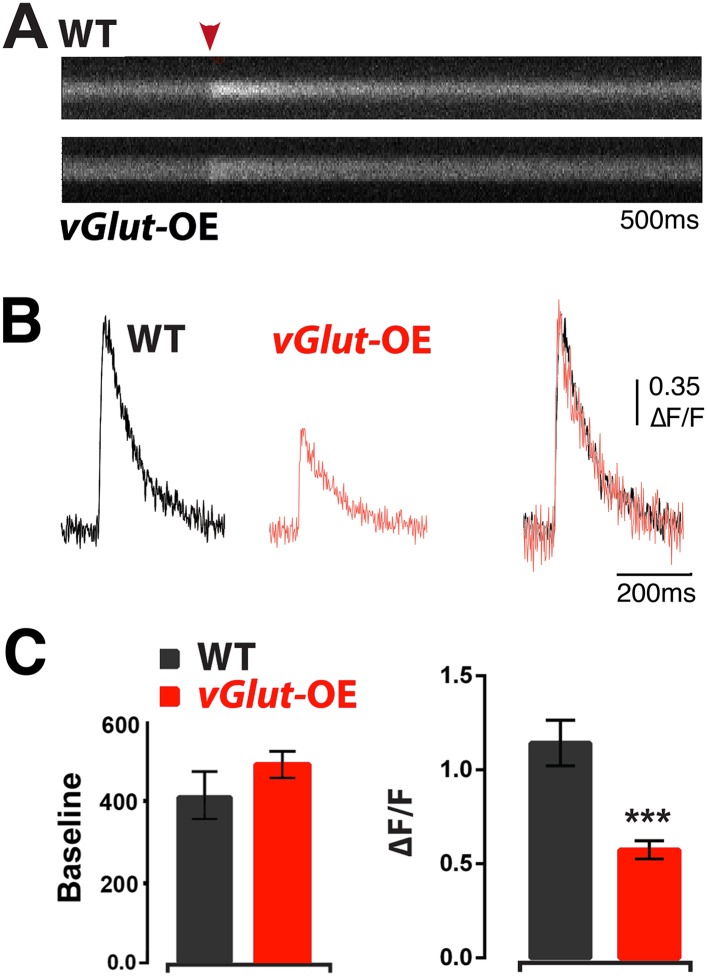
Animals expressing PHD have reduced presynaptic calcium influx.(A) Representative line-scans of WT and vGlut-OE boutons. Red arrowhead: moment of stimulation. (B) Example Ca2+ transients from WT and vGlut-OE animals. vGlut-OE transients are identical to WT when normalized by amplitude (right). (C) vGlut-OE animals displayed a ∼50% drop in ΔF/F (right) with no change in baseline OGB-1 fluorescence (left). n = 12 for WT, n = 19 for vGlut-OE, p < 0.0001, see ‘Materials and methods’ for details.